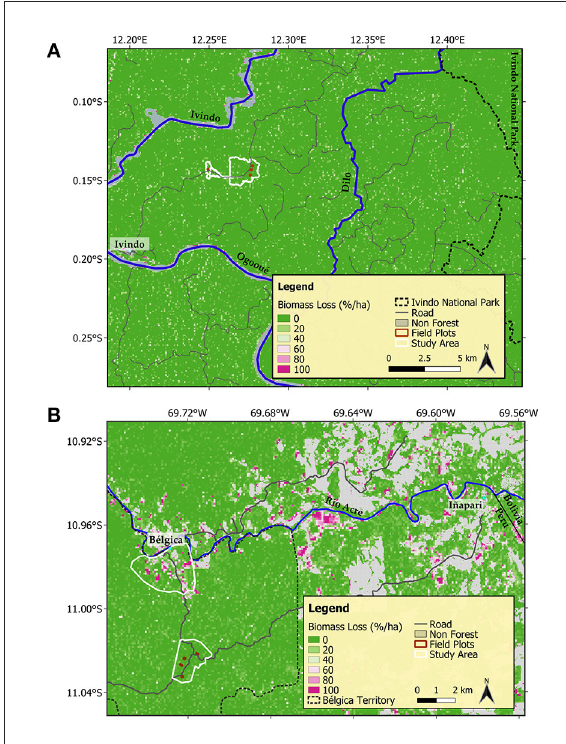
FIGURE10 Maps of above ground biomass (AGB) loss (% per hectare) for two areas in (A) Gabon and (B) Peru, with the location of the study sites (white line) and the field plots (red boxes). Non- forest areas have been masked using the primary humid tropical forest extent for the year 2001 from (Turubanova et al., 2018).